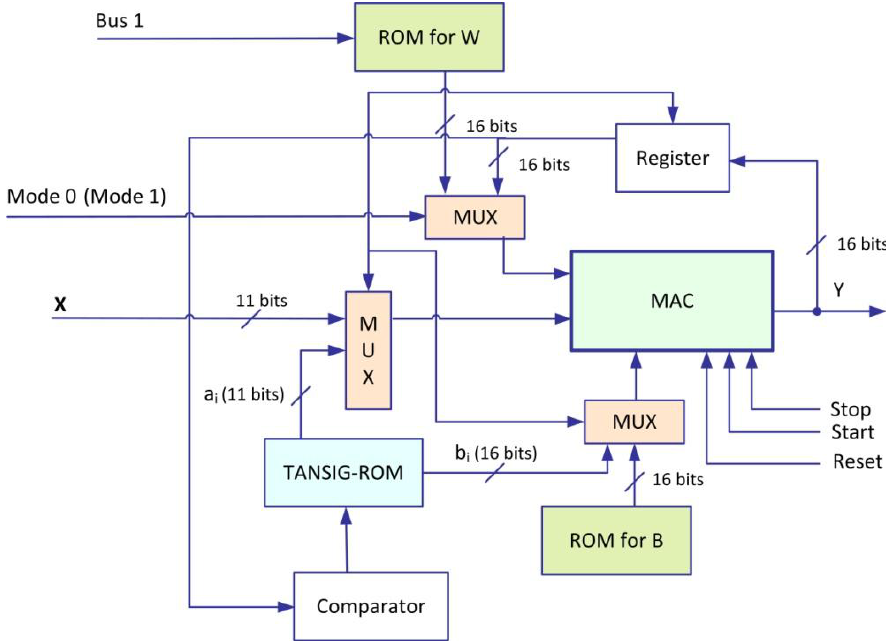
Figure 9. Schematic of digital neuron (hidden